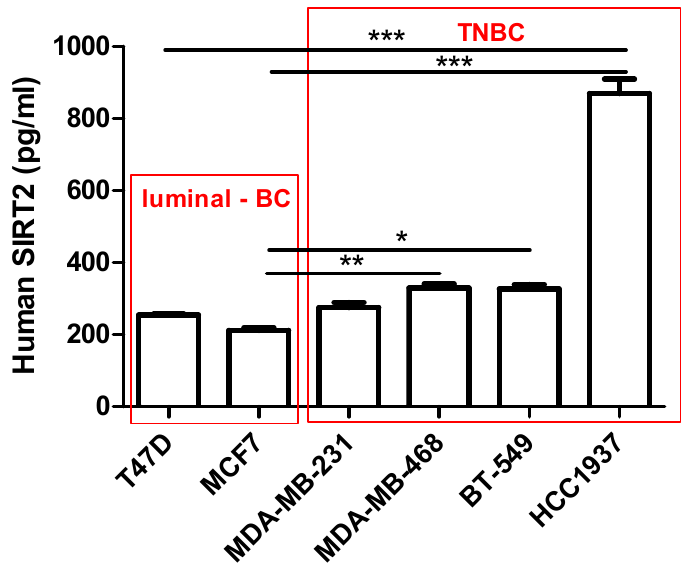
Figure 4. Interpolated concentrations of native SIRT2 (pg/mL) in 100 µg/mL of the protein extracted from the T47D, MCF7, MDA-MB-231, MDA-MB-468, BT-549 and HCC1937 BC cells. The concentrations of SIRT2 were measured in triplicate and interpolated from the SIRT2 standard curve and corrected for sample dilution. The interpolated dilution factor-corrected values are plotted (mean ± SD, n = 3; one-way ANOVA, Tukey’s post-hoc testing; * p < 0.05, ** p < 0.01, *** p < 0.001). Table 2. IC 50 ± SEM for AGK2 and paclitaxel (PAX) for the T47D, MCF7, MDA-MB-231, MDA-MB- 468, BT-549 and HCC1937 BC cells. N—number of items; SR—slope function ratio (S PAX /S AGK2 ); f ratio SR—factor for the slope function ratio; NP—not parallel; P—parallel. The test for parallelism of the two concentration–effect curves for PAX and AGK2 was performed according to Litchfield and Wilcoxon